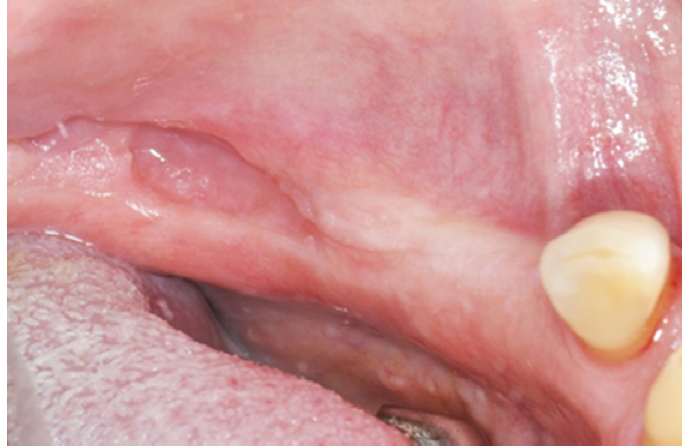
Figure 6. Complete healing of the lesion.